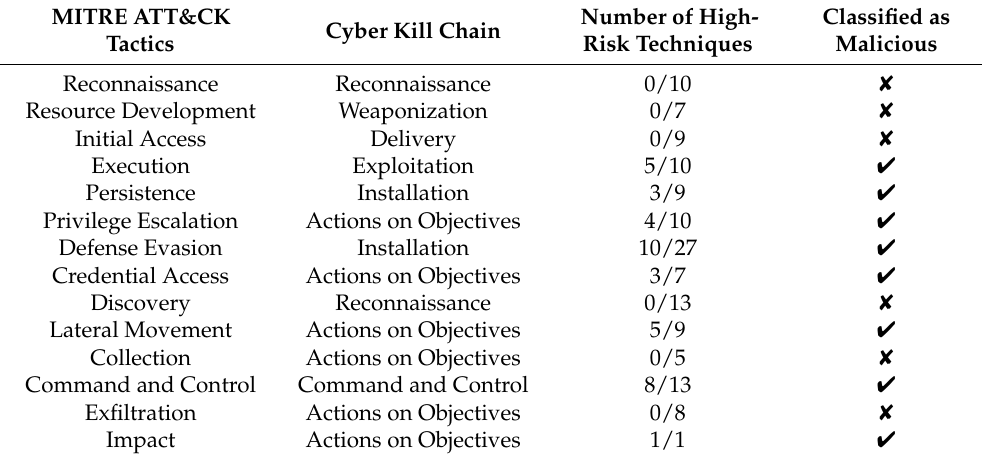
Table 1. Classification method using MITRE ATT&CK matrix and Cyber Kill Chain. MITRE